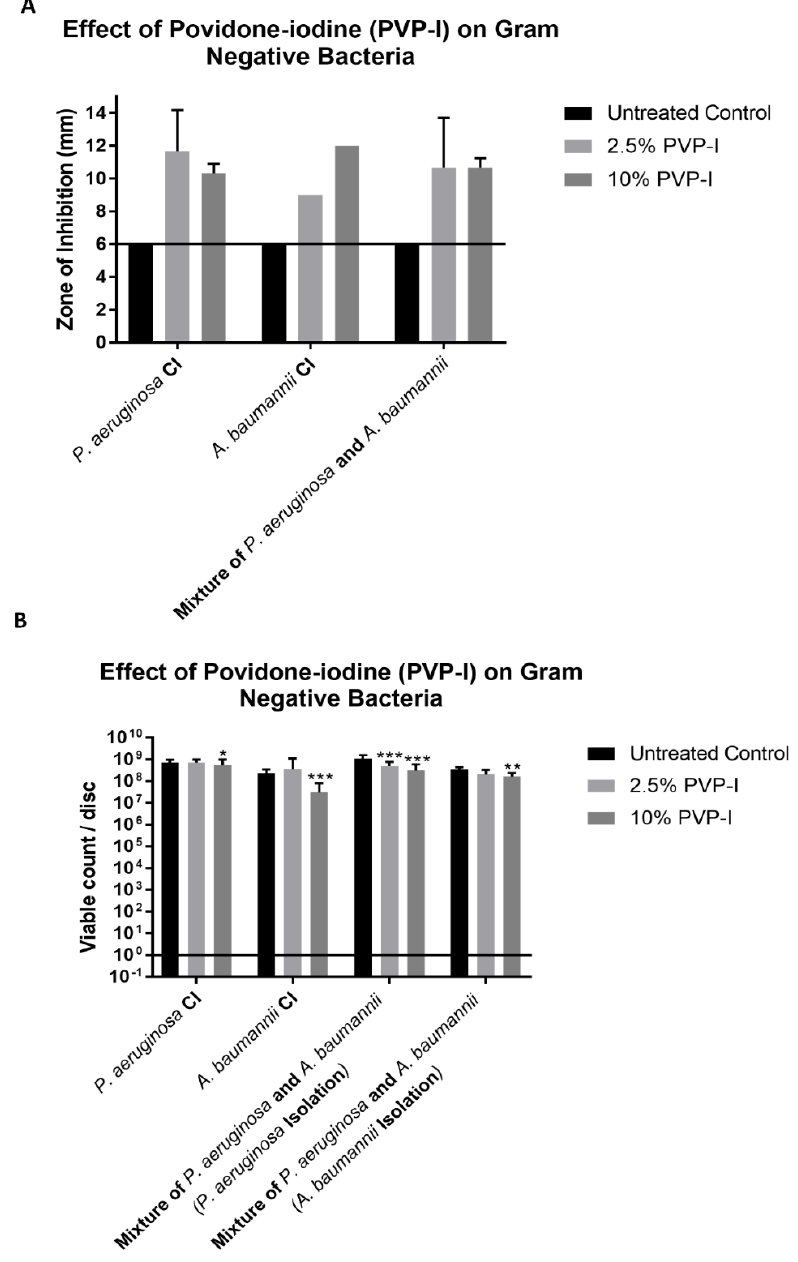
Figure 2. ( A ) The ZOI of gram-negative bacteria on the discs were measured in mm. ( B ) The bacteria remaining on the disc was quantified by the CFU assay. The different numbers of stars represent significance: * p < 0.05, ** p < 0.01, and *** p < 0.001.